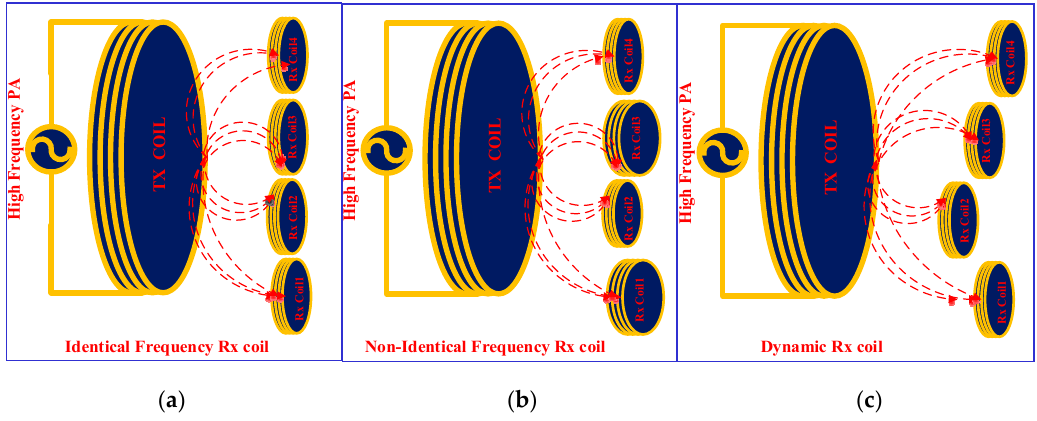
Figure 1. Possible dynamic receiver configuration. ( a ) Identical Rx’s; ( b ) Nonidentical Rx’s; ( c ) Dynamic